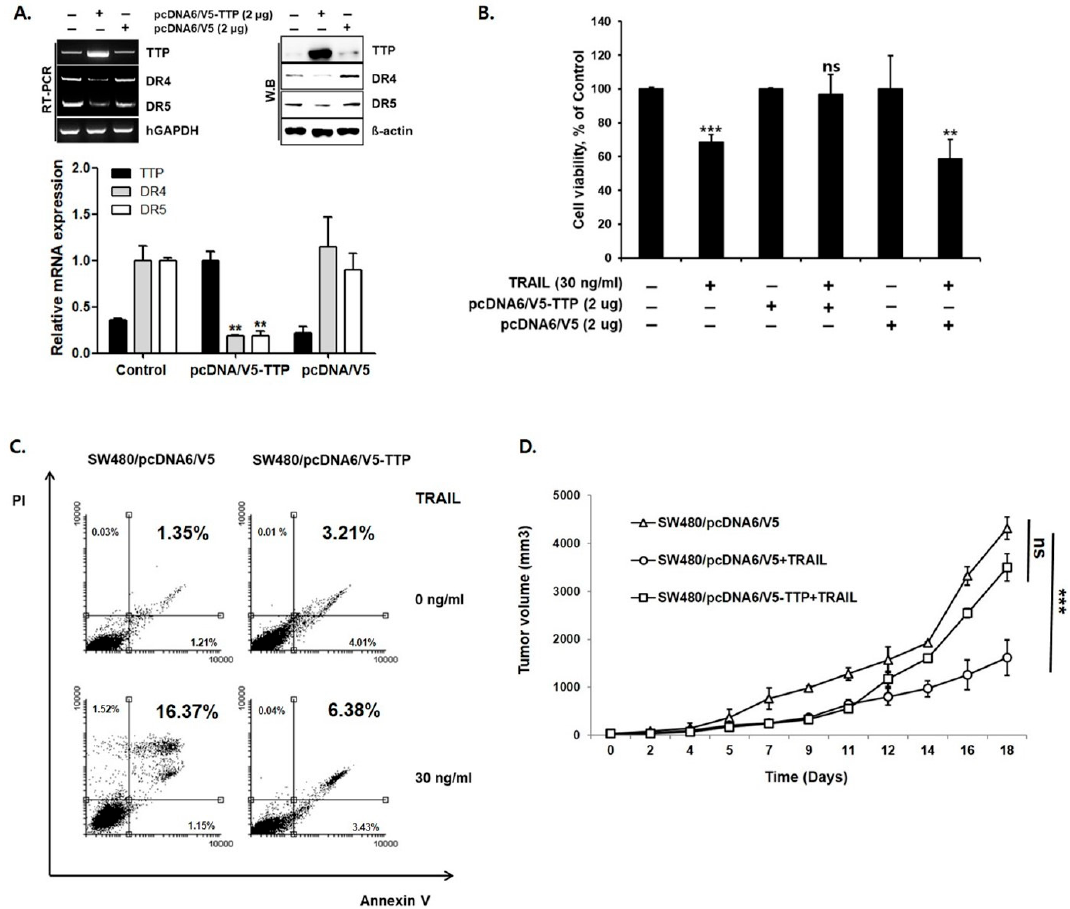
Figure 2. Overexpression of TTP reduced DR4/5 expression. ( A ) Expression of TTP and DR4/5 in SW480/pcDNA and SW480/TTP was determined by quantitative real-time PCR and Western blot analysis. MTS assay ( B ) and annexin V-FITC/PI staining assay ( C ) in TTP-overexpressed SW480/TTP show significant resistance to TRAIL treatment. ( D ) In vivo antitumor activity of TRAIL in TTP-overexpressed SW480 cells. When dorsal flank tumors were approximately 200 mm 3 , mice in each treatment group were treated with intratumoral injection of TRAIL (0.2 mg/kg twice per week for two weeks). The Control group received only normal saline. TTP overexpression in SW480/TTP cells shows significant TRAIL resistance. ** p < 0.01; *** p < 0.001.